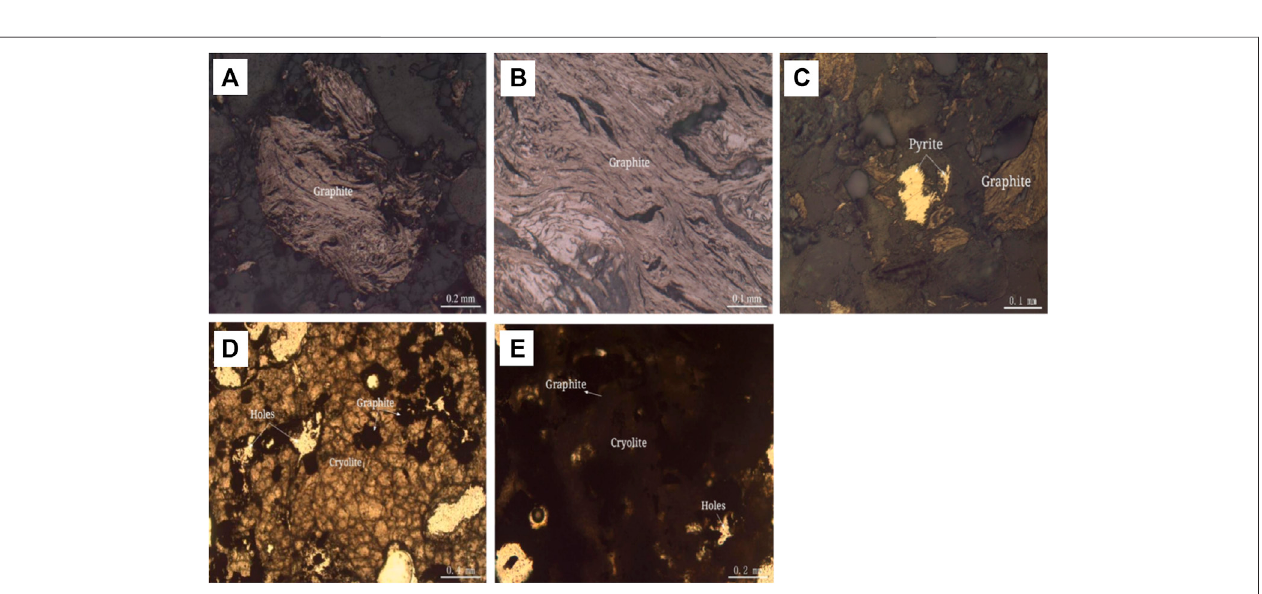
FIGURE1| StructureDiagramofAnodeCarbonResidue. (A – D) Manypores,cryoliteandgraphitearelocallyenriched; (E,F) Multiplepores,alternatingdistribution of cryolite and graphite.